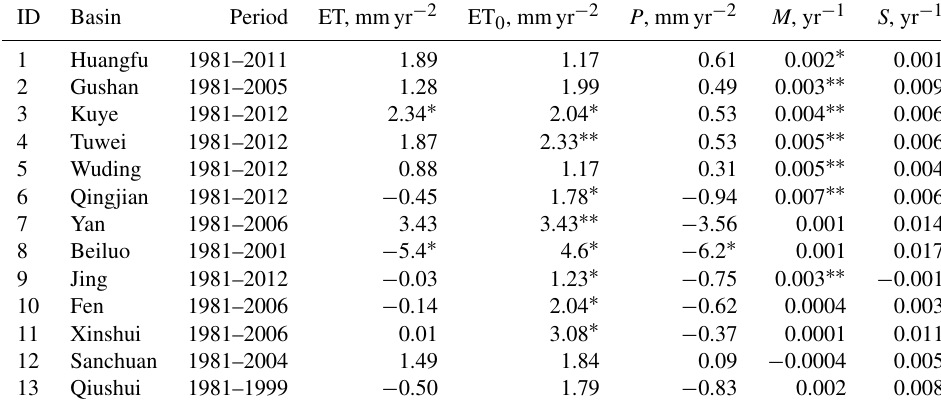
Table 3. Trend analysis for the hydrometeorological variables and vegetation